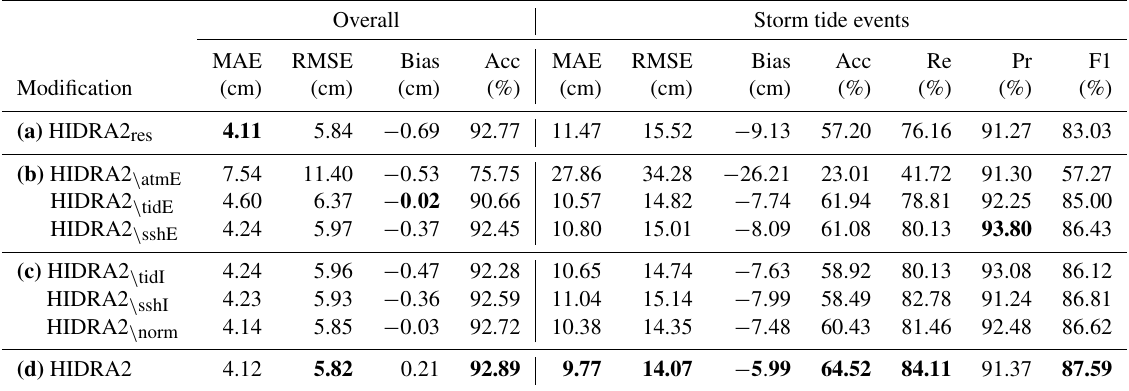
Table 1. Performance of ablated HIDRA2 designs evaluated over all sea level bins (the Overall column) and only on storm tide events ( Storm tide events column). The evaluation period spans 1 June 2019–31 December 2020, which is completely independent of the training data. Row (a) shows the performance of HIDRA2 in predicting the residual, row (b) shows the performances of encoder ablations, and row (c) corresponds to SSH input ablations and re-calibration. The final row (d) corresponds to the final version of HIDRA2. The best scores are formatted in